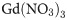
FTIR spectra of GO nanosheets (A), pure chlorogenic acid (B), GdNO33 (C) GO/Gd conjugated with chlorogenic acid (GOGCA) (D) and the bimodal theranostic nanodelivery system [(BIT) GOGCA coated with AuNPs] (E).